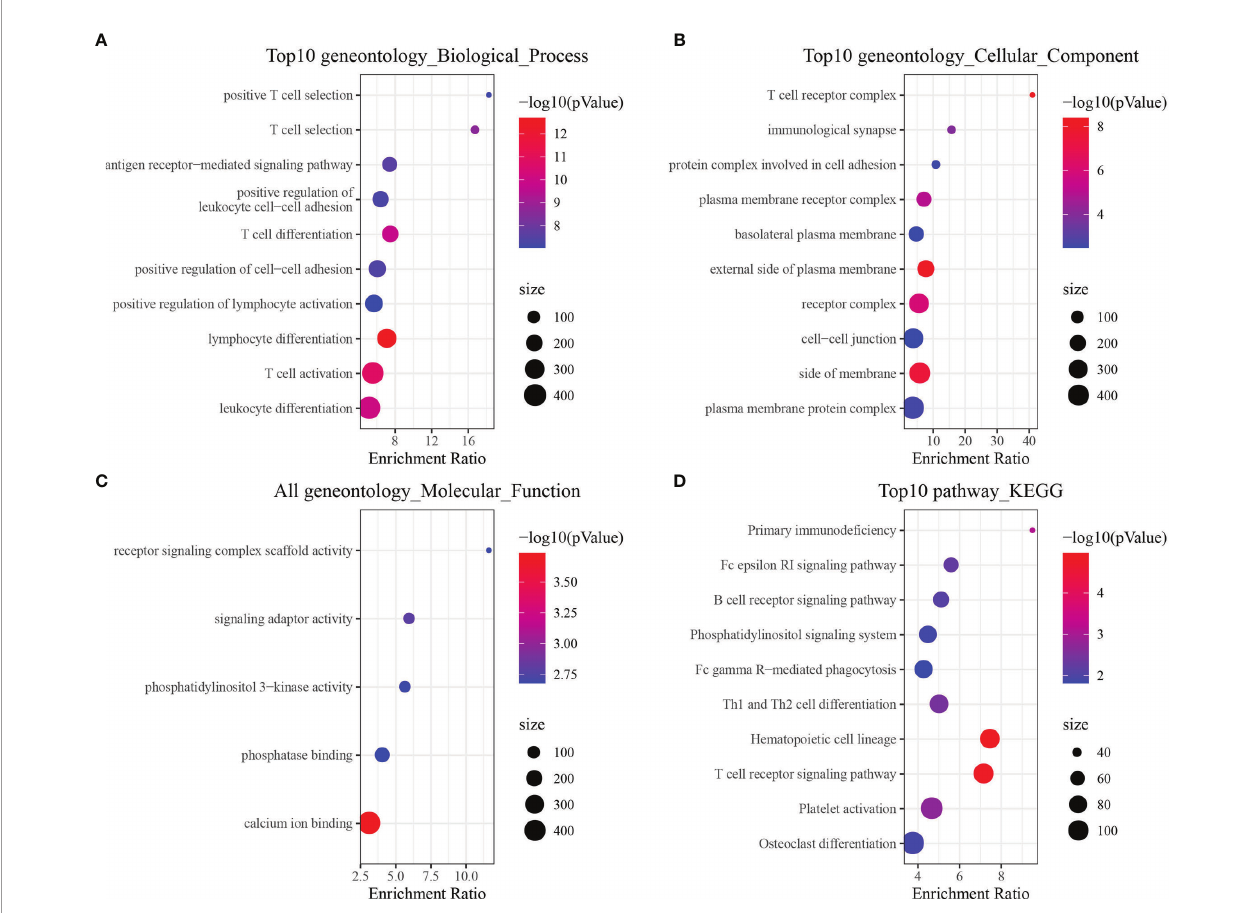
FIGURE 2 | Functional enrichment analysis of CD8 + T cell-associated genes. (A) Biological process annotation map of genes in the cyan-colored module. (B) Molecular function annotation map of genes in the cyan-colored module. (C) Cellular component annotation map of genes in the cyan-colored module. (D) Kyoto Encyclopedia of Genes and Genomes annotation map of genes in the cyan-colored